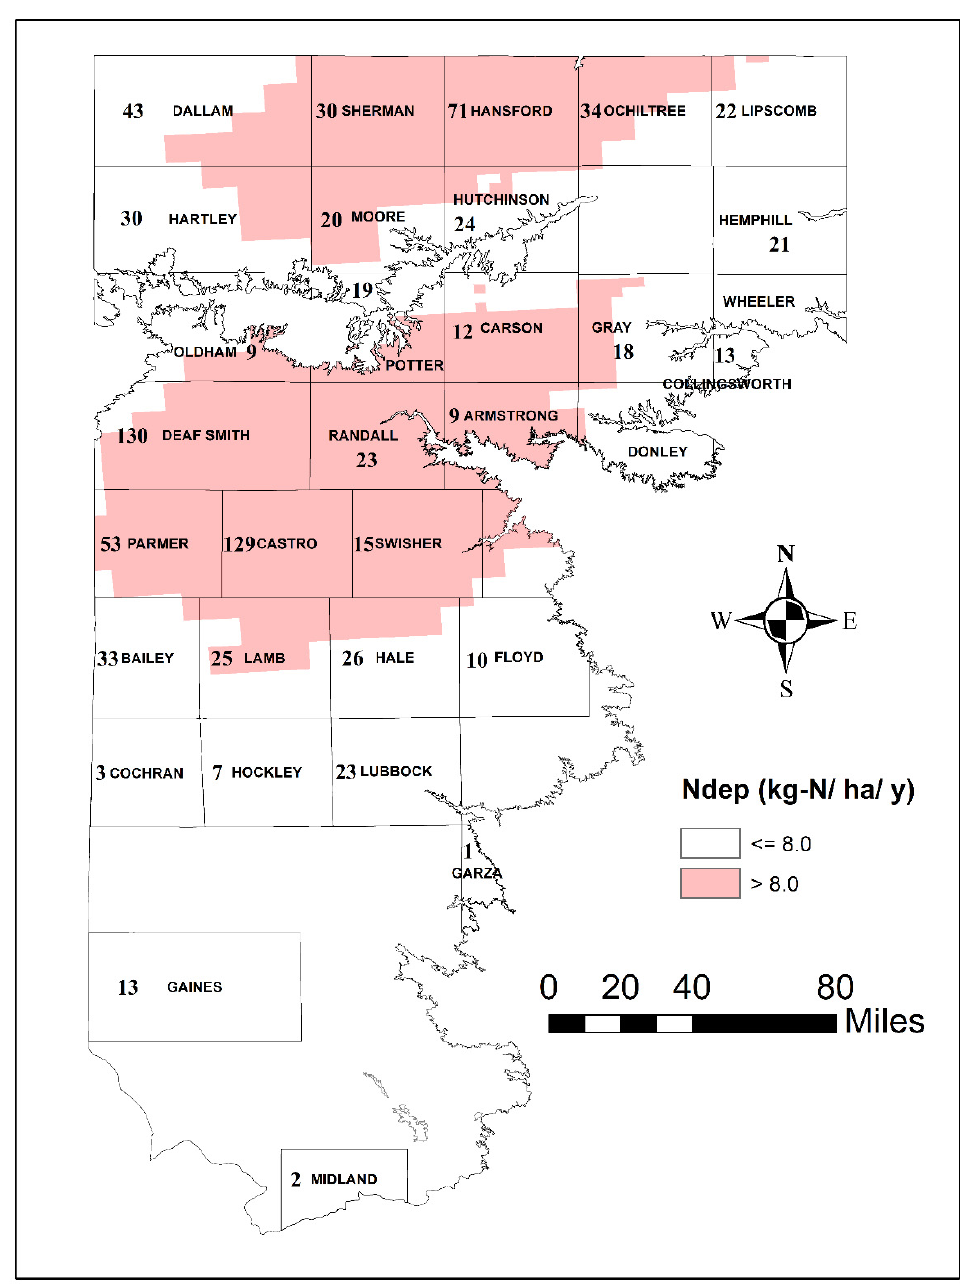
Figure 7. Number of Confined Animal Feed Lot Operations (CAFOs) in each County of the Study Area, along with Estimated Annual Nitrogen Deposition (Ndep).